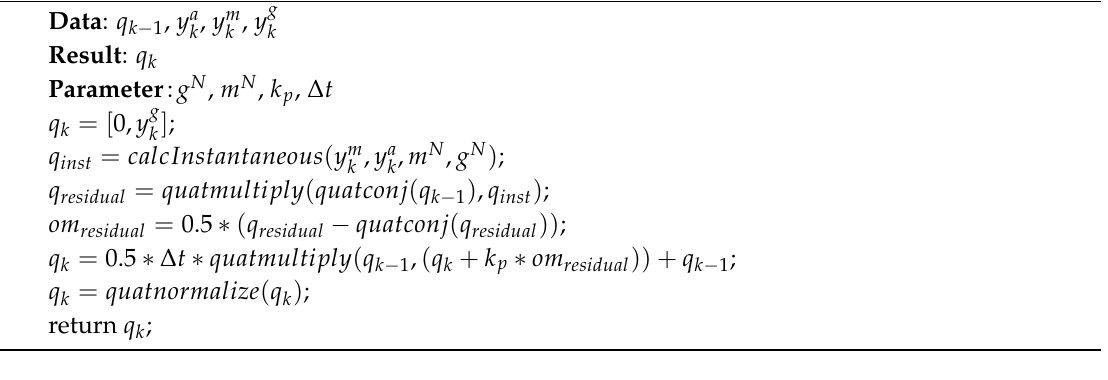
Algorithm 1: Nonlinear complementary filter pseudo code (Matlab style)